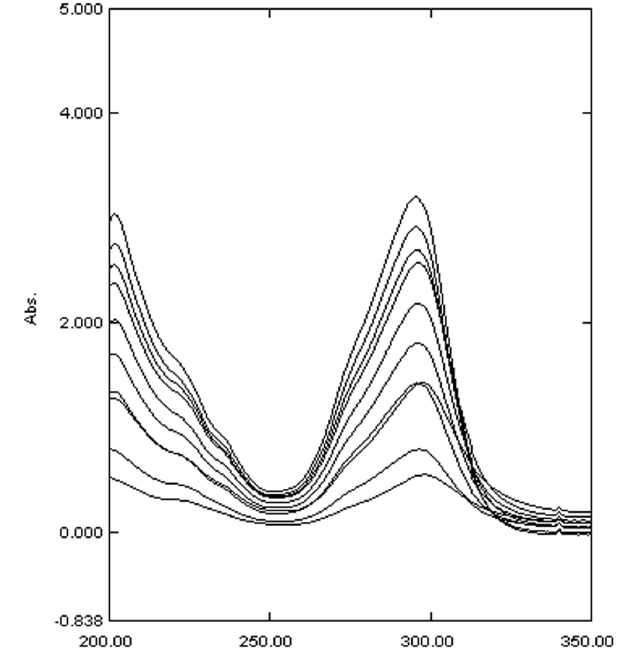
FIGURE 4 - Ratio spectra of DS by DC5.